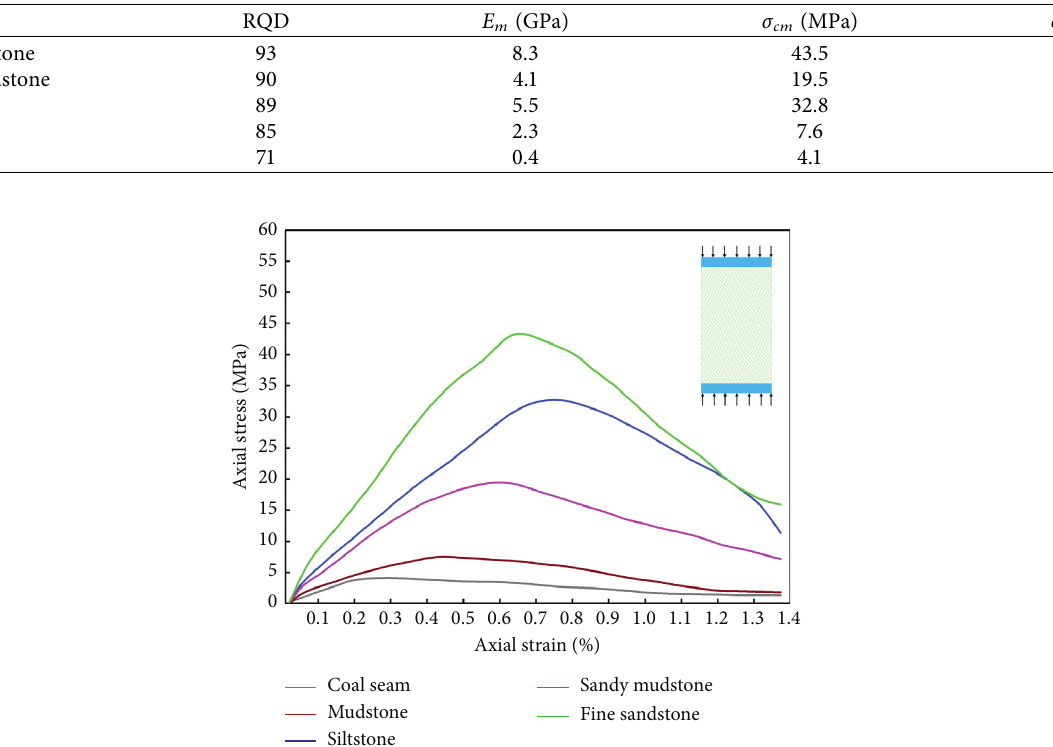
Table 2: The mechanical parameters of the rock mass.